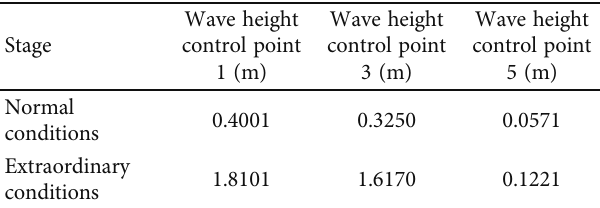
Table 3: Average wave height referred to below mean low water level for viewers 1, 3, and 5.